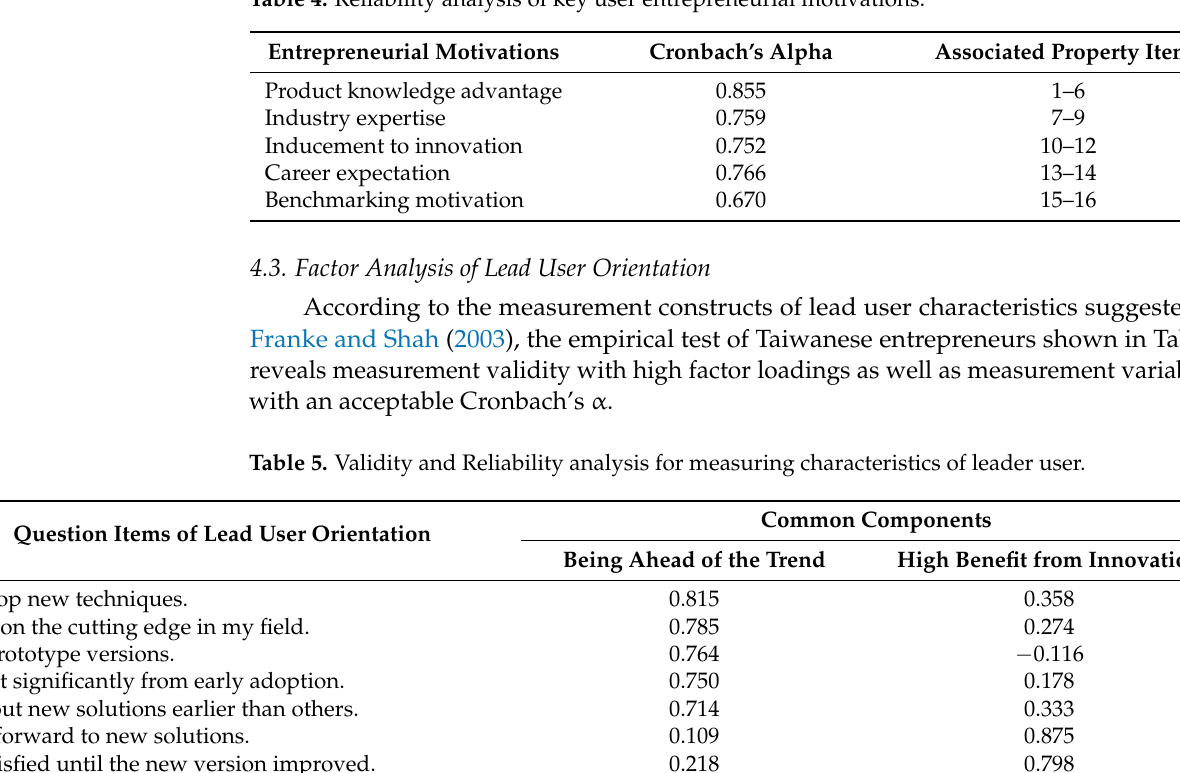
Table 4. Reliability analysis of key user entrepreneurial motivations.